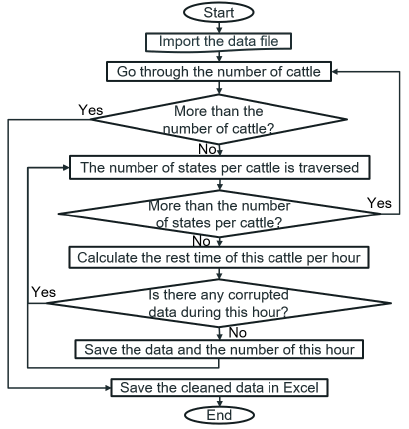
Figure 1. Process flow chart of data cleaning.